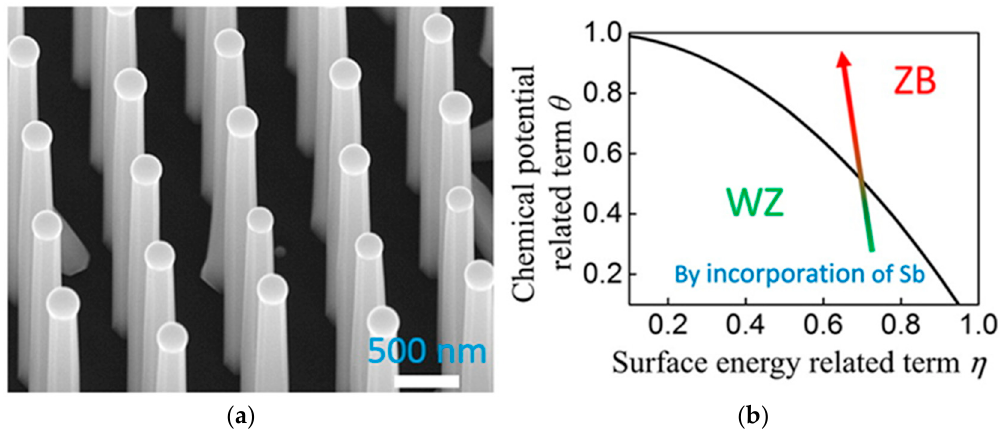
Figure 16. ( a ) SEM images of GaAsSb NW arrays and ( b ) WZ-ZB crystal phase diagram for catalyst-assisted NW growth. The solid lines show the WZ-ZB nanowire crystal phase-equilibriumlines with respect to η and θ . The labeled arrows represent how the crystal phase diagrams correlate with different crystal phase control strategies. Reproduced with permission from [80], copyright American Chemical Society (2016).